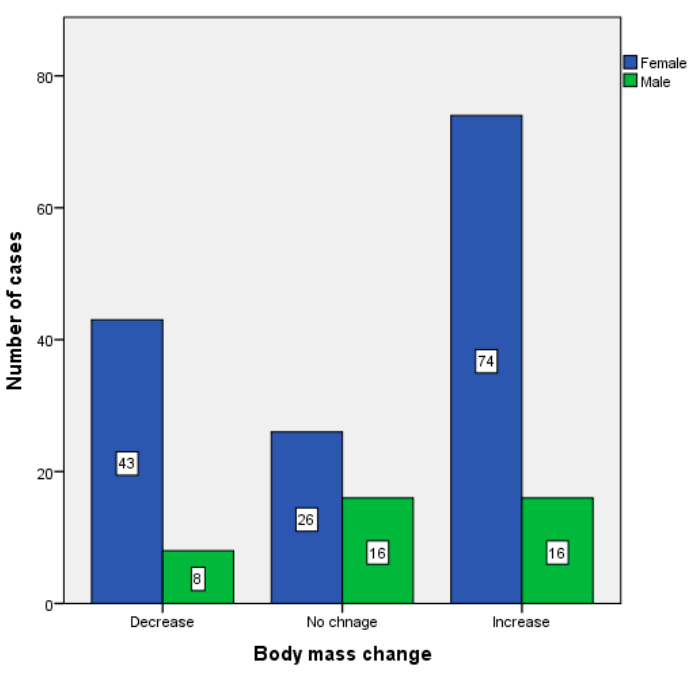
Figure 1. Change in body mass depending on sex in the study group during the lockdown. According to 20.2% of the respondents ( n = 37), changes in body weight did not occur. Other study participants reported that the most common causes of changes in Table 1. Changes in body mass and energy needs in the study group during the lockdown ( n = 183). body weight were decreased physical activity (35%; n = 64) and the change of diet (20.2%; n = 37). Subsequently, there were changes in professional life ( n = 18; 9.8%) and psychologi- cal factors ( n = 14; 7.7%). Three participants (1.6%) indicated that the change in body weight Phase occurred as a result of a food availability change, and 10 participants (5.5%) indicated other factors. The vast majority of study participants ( n = 121; 66.1%) indicated no changes in the performance of heavy household